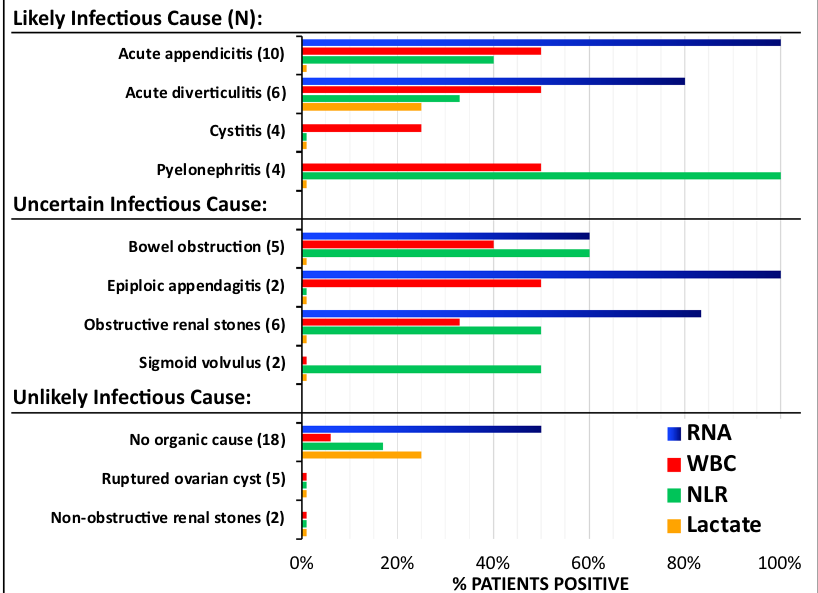
Figure 3. Comparison of RNA biomarkers with traditional biomarkers (WBC, NLR, Lactate). The clinical, imaging, and laboratory values of patients presenting with abdominal pain at the Emergency Department was used to categorize the patients into the diagnostic groups shown on the Y-axis. The percent of those patients that were positive for the novel RNA biomarkers DEFA1 > 5% or ALPL + IL8RB > 20% (BLUE bars), WBC count > 10k/μL (RED bars), neutrophil/lymphocyte ratio > 6 (NLR, GREEN bars), and lactate levels > 2 mM in plasma (YELLOW bars) are shown on the horizontal axis. Lactate was not ordered on all patients, but only one diagnosis (obstructive renal stones) had no cases where lactate was ordered.